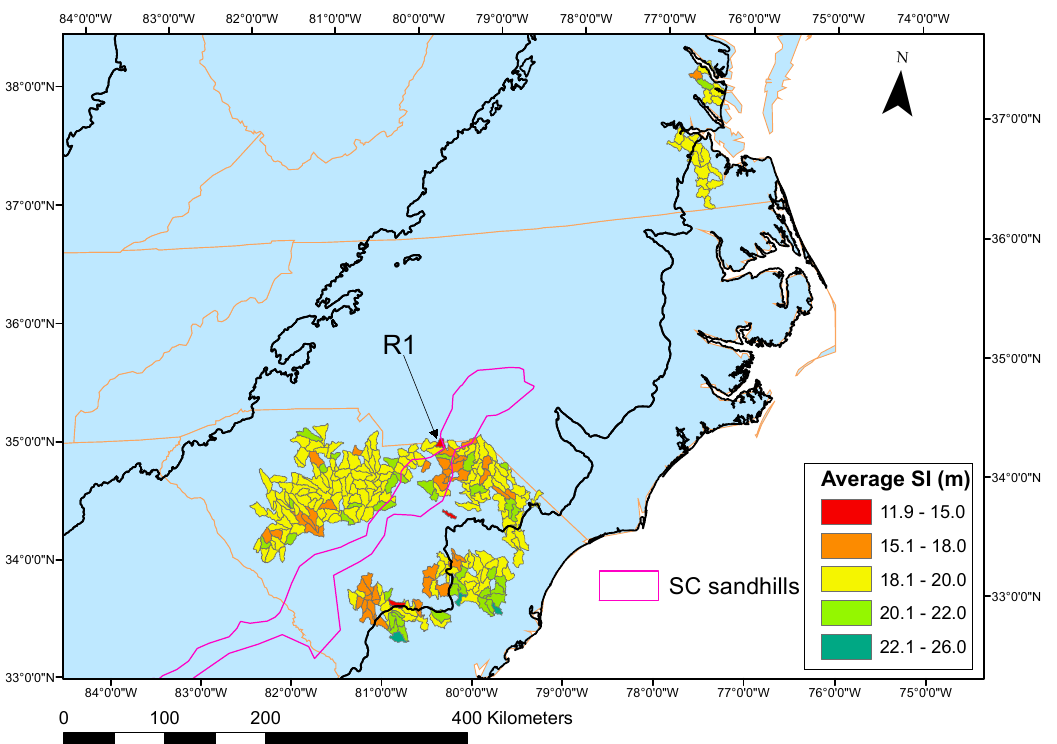
Figure 9. The average site index for all stands that fall in a given hydrological unit is depicted. Only hydrological units with at least 4.5 ha of surveyed forest stand area (50 pixels) are shown. The thick black lines demarcate EPA level 2 ecoregions (as per Omernik (1987) [44]), see text for more details. The polygon with the pink outline roughly demarcates the South Carolina sandhills region, where low productivity has been documented [47]. The general region pointed to by text “R1” in the map, i.e., the 6–7 HUCs with estimated low productivity (18.0 and lower) all seem to lie in this region. This seems to indicate that our ALS-based site index map can effectively identify regions of low